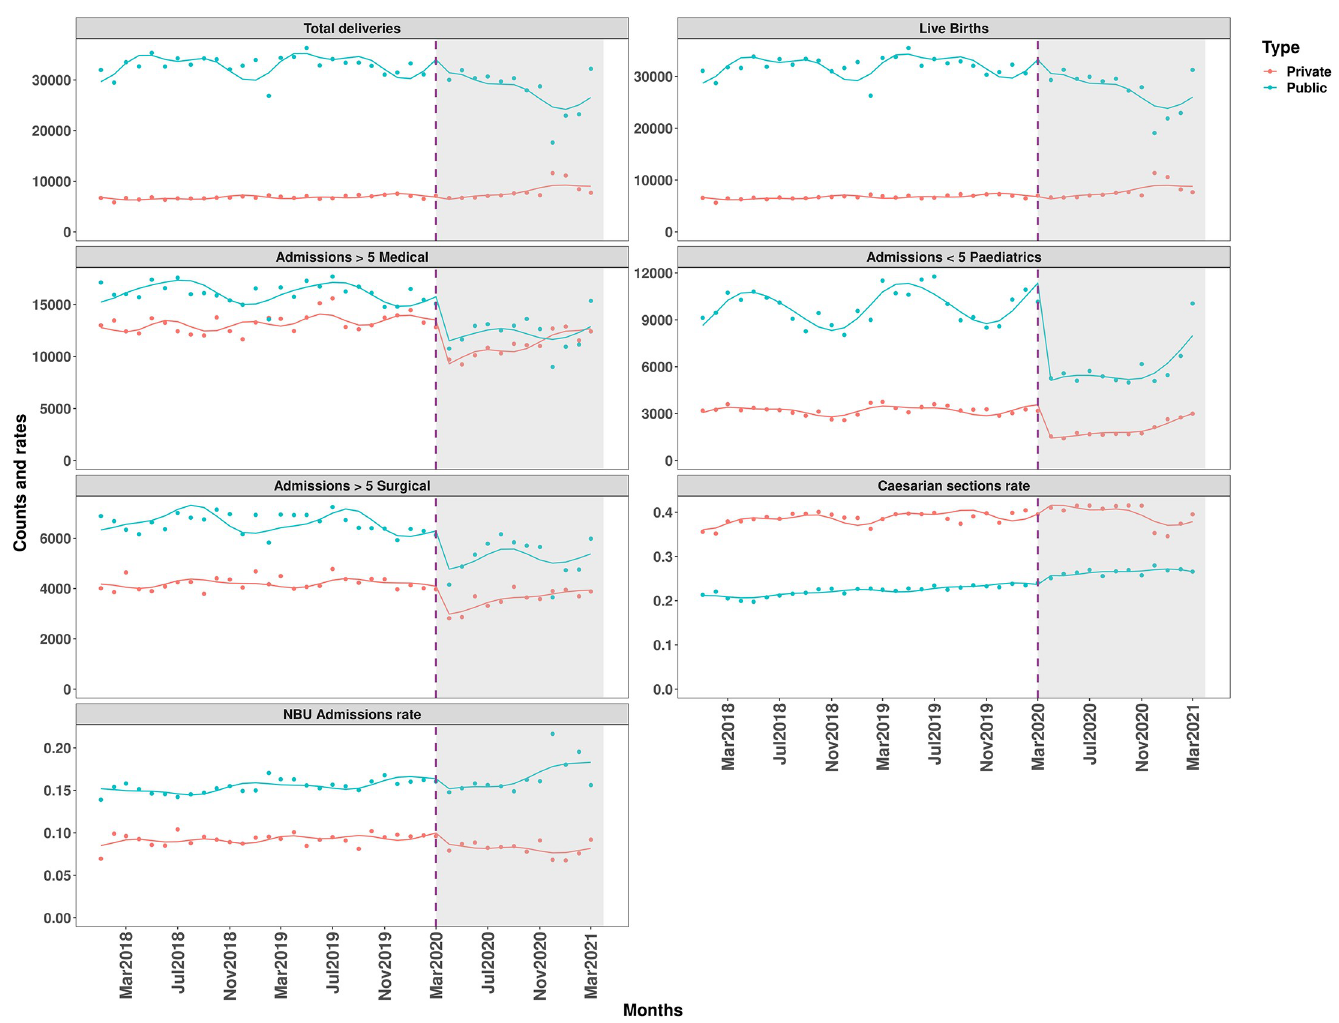
Fig 3. Fitted lines of segmented regression models for all indicators and by hospital ownership. Vertical lines represent the month (March 2020) COVID-19 was announced in Kenya and as a pandemic by the